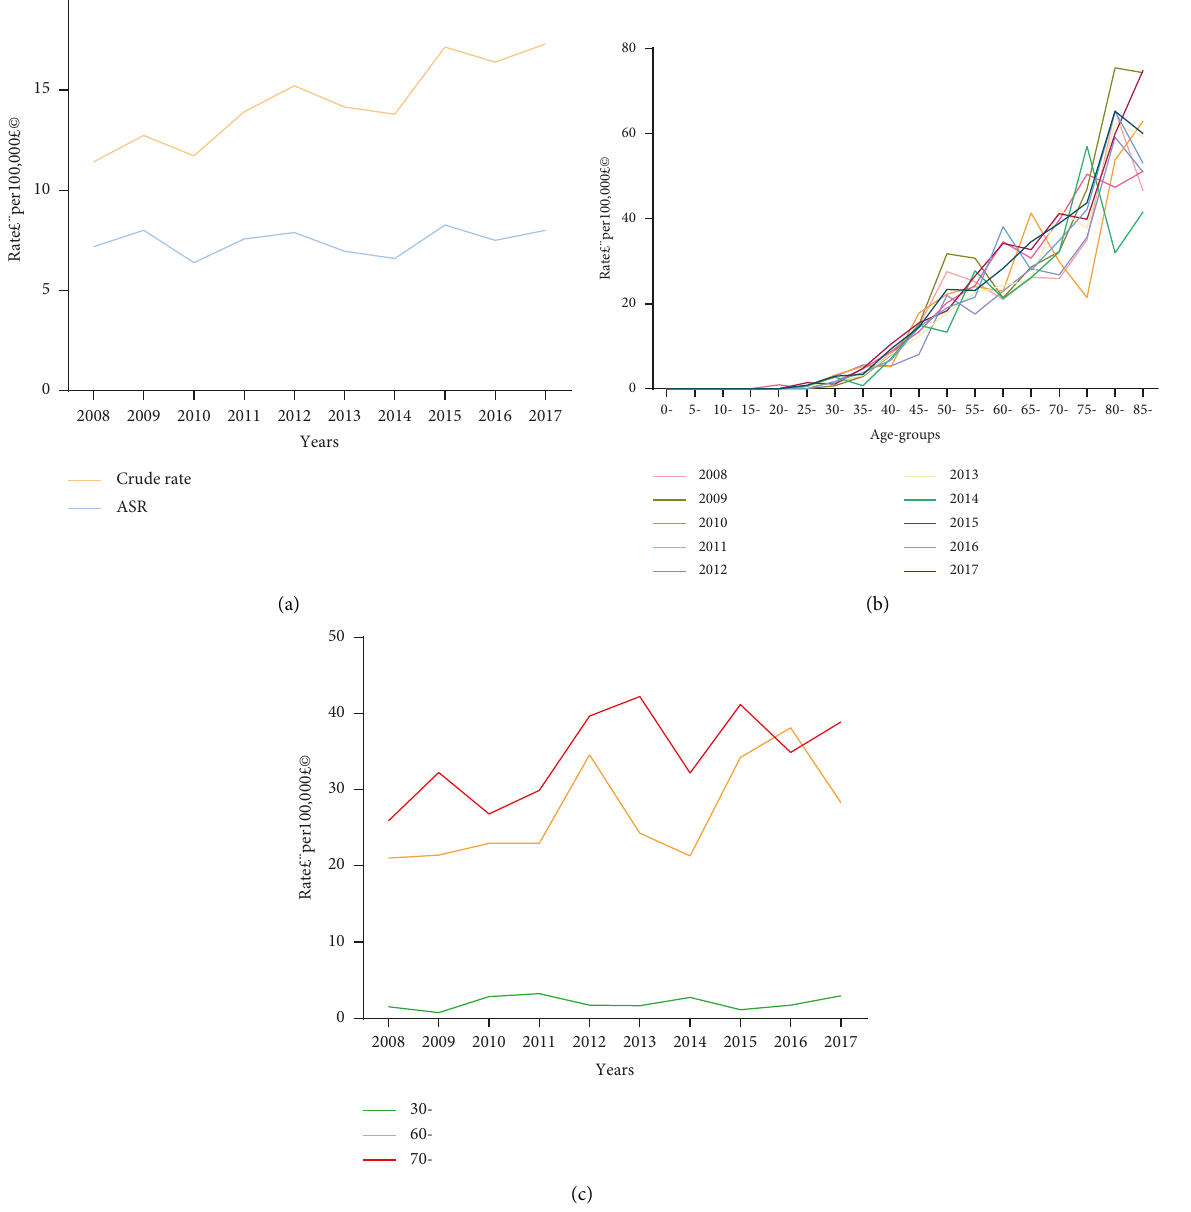
Figure 2: Mortality of female breast cancer in urban Shenyang in 2008–2017. (a) Overall mortality rates; (b) age-specific mortality rates; (c) age-specific mortality trends in three age groups over time. The 30–34 years, 70–74 years, and 60–64 years age groups showed the most increase in mortality over time. Abbreviations: ASR, age-standardized mortality